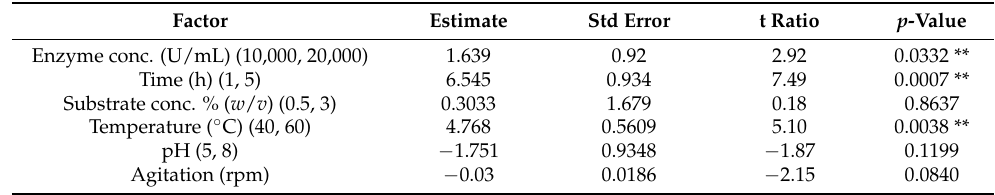
Table 12. Estimatedeffects, correspondingtratios, and p -valuesforthePlackett–Burmandesignexperiment. Factor Estimate Std Error t